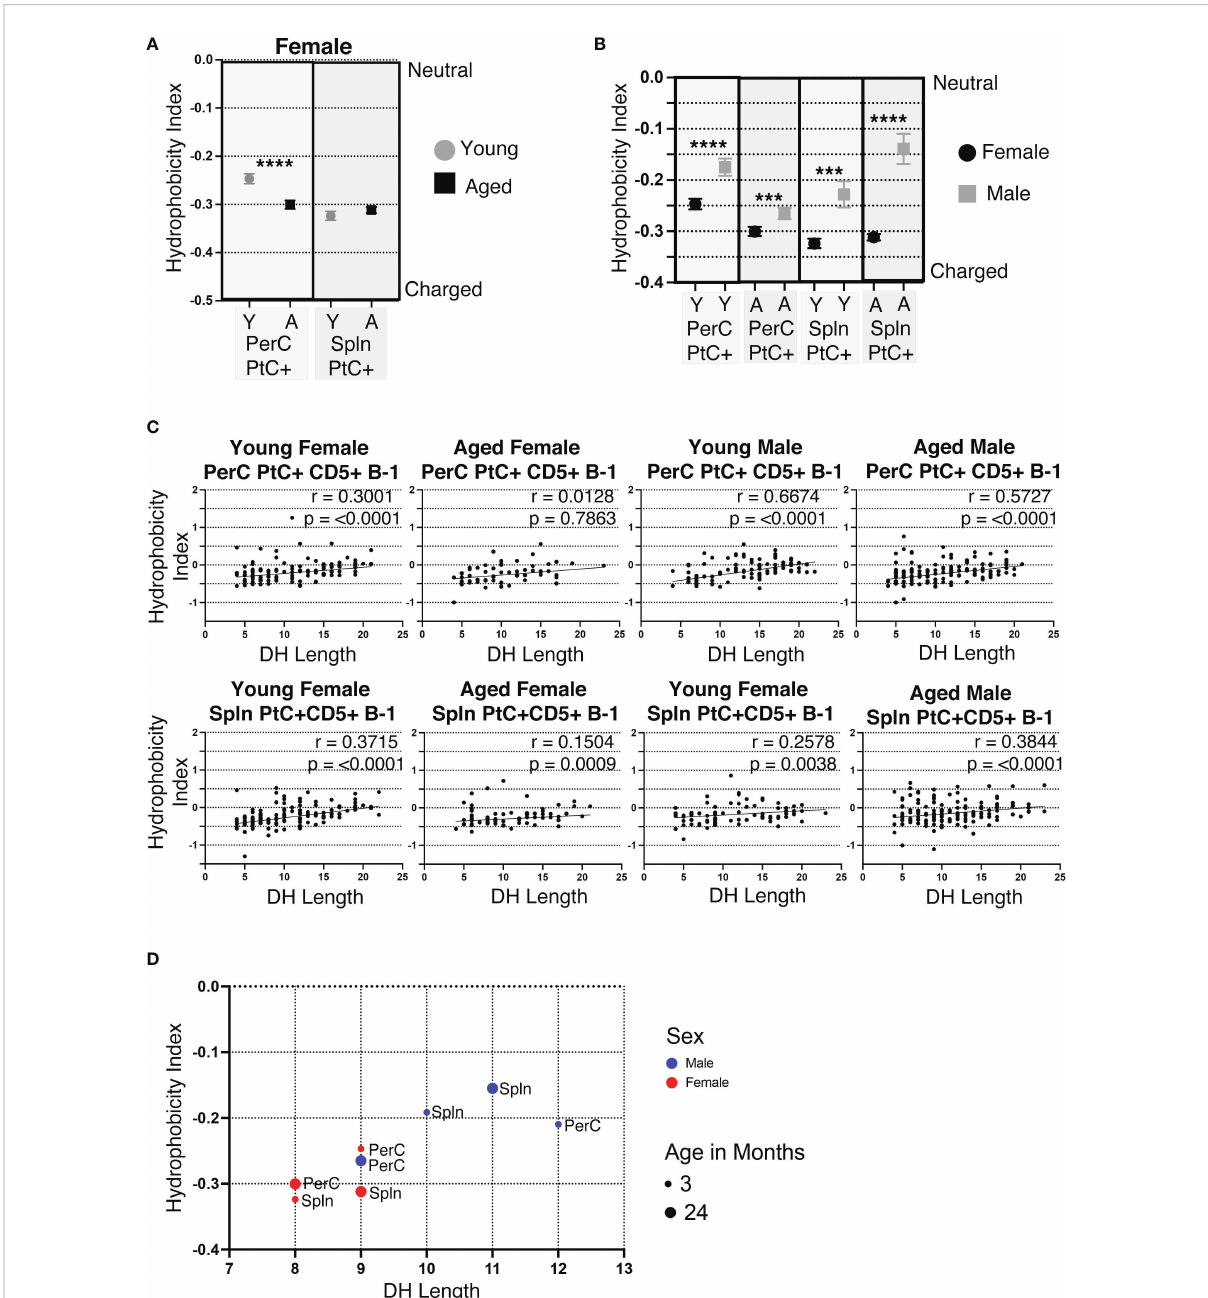
FIGURE 5 CDR-H3 hydrophobicity of PtC+CD5+ B-1 cell IgM changes with age and sex. PtC+CD5+ B-1 cells were single-cell sorted from the peritoneal cavity or spleen of young and aged female BALB/c-ByJ mice (as presented in Figure 2). “ Y ” indicates young mice (3-month-old) and “ A ” indicates aged (23-26-month-old) mice. (A) The average charge of the CDR-H3 loop region of IgM from the peritoneal or splenic PtC+CD5+ B-1 cells. (B-D) For direct comparison of females and males, previously published (24) hydrophobicity analysis of young and aged male PtC +CD5+ B-1 cells is included. (B) Female and male comparison of the average charge of the CDR-H3 loop region of IgM from peritoneal or splenic PtC+CD5+ B-1 cells. (C, D) Correlation of average charge of the CDR-H3 loop region with DH length. Results are based on 4 independent experiments with sequences combined from each independent experiment (n=11 for 3-month-old mice, n=15 for 23-26-month- old female mice). Statistics used: Mann-Whitney test for (A, B) and Spearman ’ s rank correlation coef fi cient (C) . Asterisks for p values: ***p<0.001,